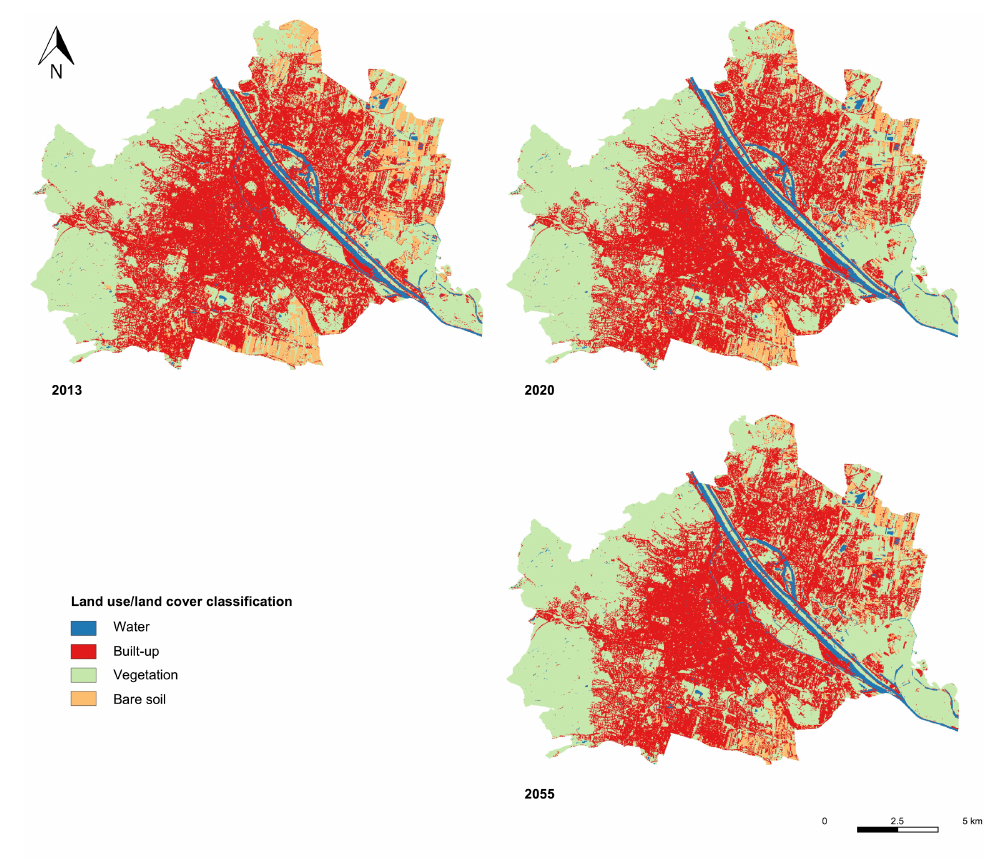
Figure 1. Land use/cover classification of Vienna.